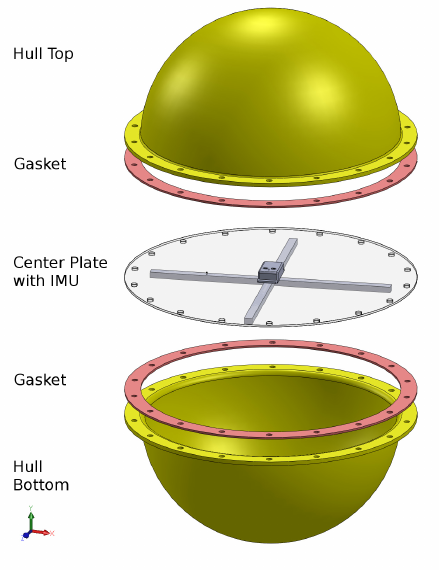
Figure 1. Exploded view of the developed wave measurement buoy hull